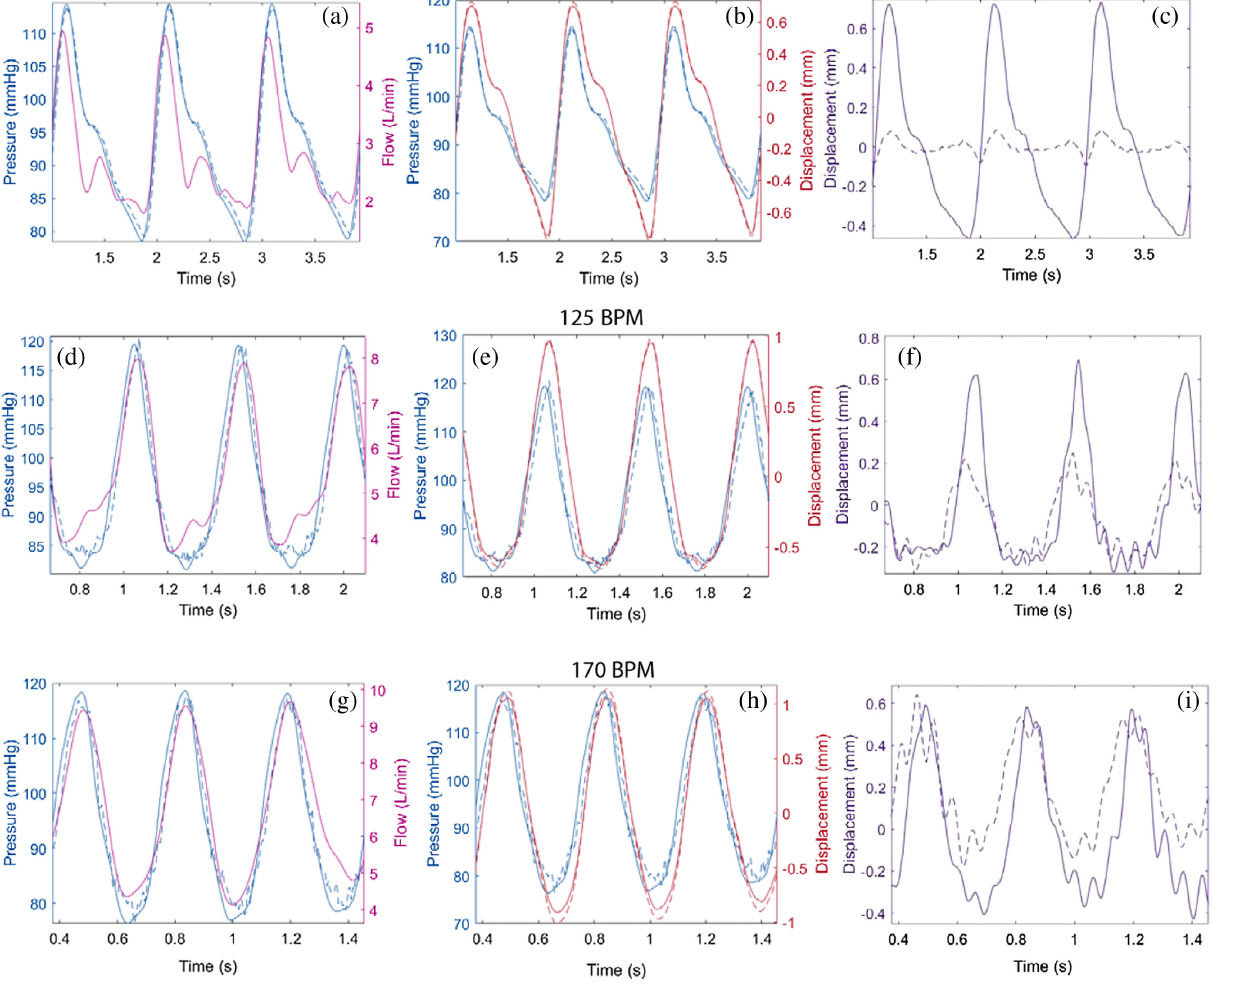
FIG. 3. Time responses of the aorta segment from donor XI at 60 bpm: (a) fluid variables; (b) cyclic change of the aortic diameter and pressures; (c) cyclic bending oscillation of the aortic segment; at 125 bpm: (d) fluid variables; (e) cyclic change of the aortic diameter and pressures; (f) cyclic bending oscillation of the aortic segment; at 170 bpm: (g) fluid variables; (h) cyclic change of the aortic diameter and pressures; (i) cyclic bending oscillation of the aortic segment. Blue line, inlet pressure; blue dashed line outlet pressure; pink line outlet flowrate; red line change of the aortic diameter measured in vertical direction at mid-length of the aortic segment; red dashed line, change of the aortic diameter measured in horizontal direction; violet line bending amplitude at mid-length of the aortic segment measured in vertical direction; violet dashed line bending amplitude measured in horizontal